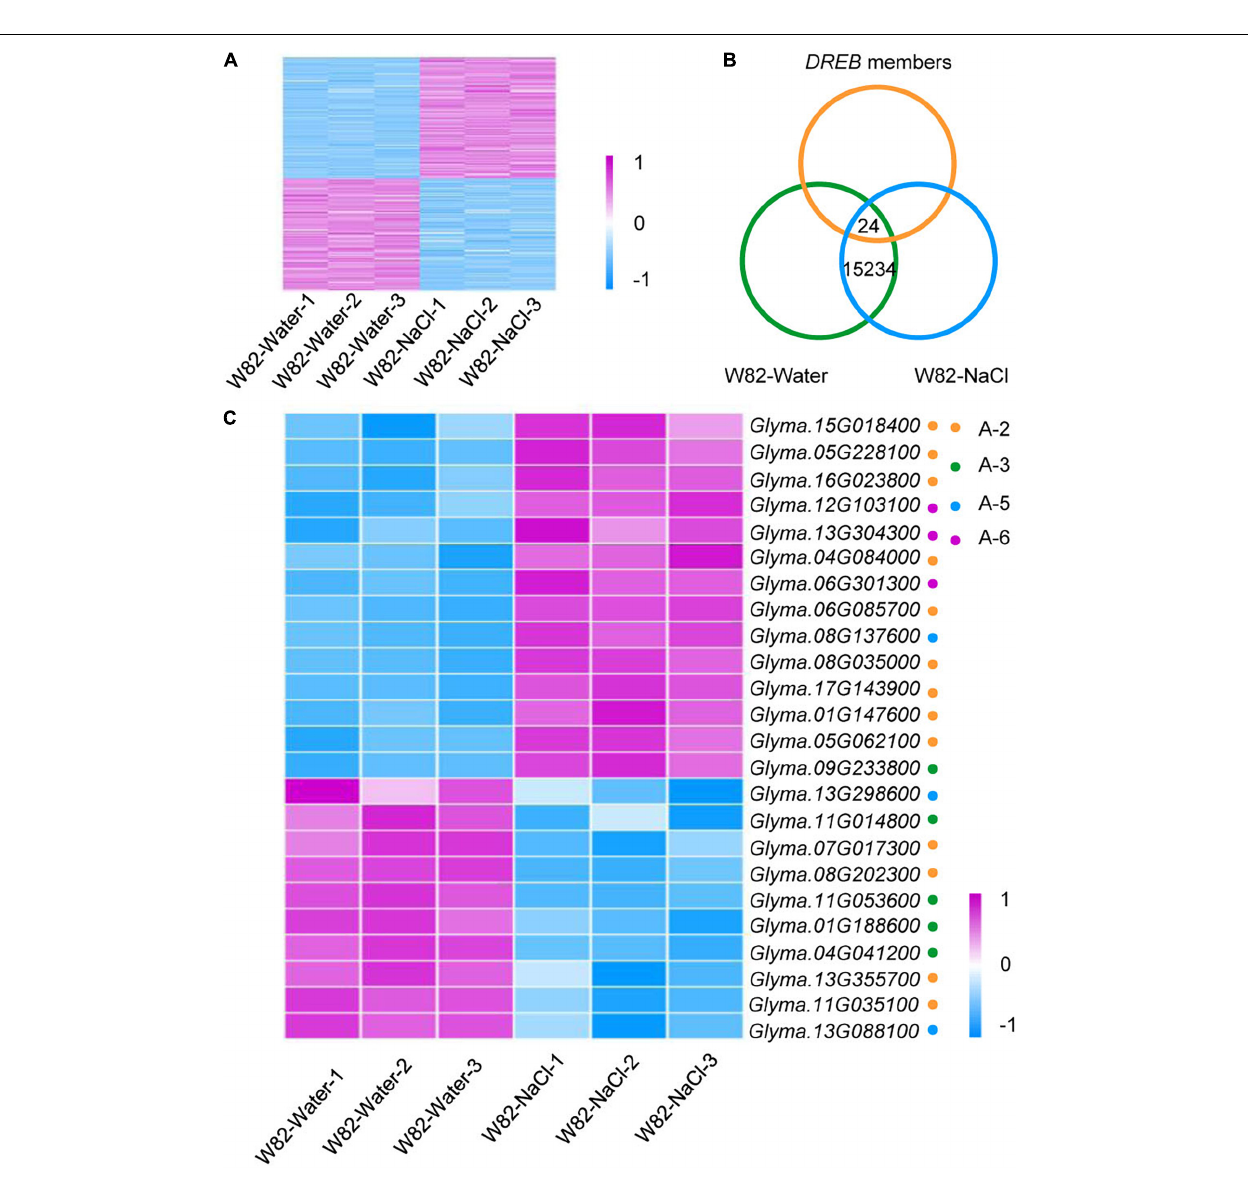
FIGURE 3 | Identification of differentially expressed DREB genes in NaCl-treated W82 vs. mock treated. (A) Heat map of differentially expressed genes in W82-Water and W82-NaCl; n = 3 for each group. Relative transcript level is indicated on a color scale from purple (high) to blue (low). (B) Overlap between W82-Water, W82-NaCl and DREB genes. (C) Heat map of differentially expressed 24 DREB genes under NaCl